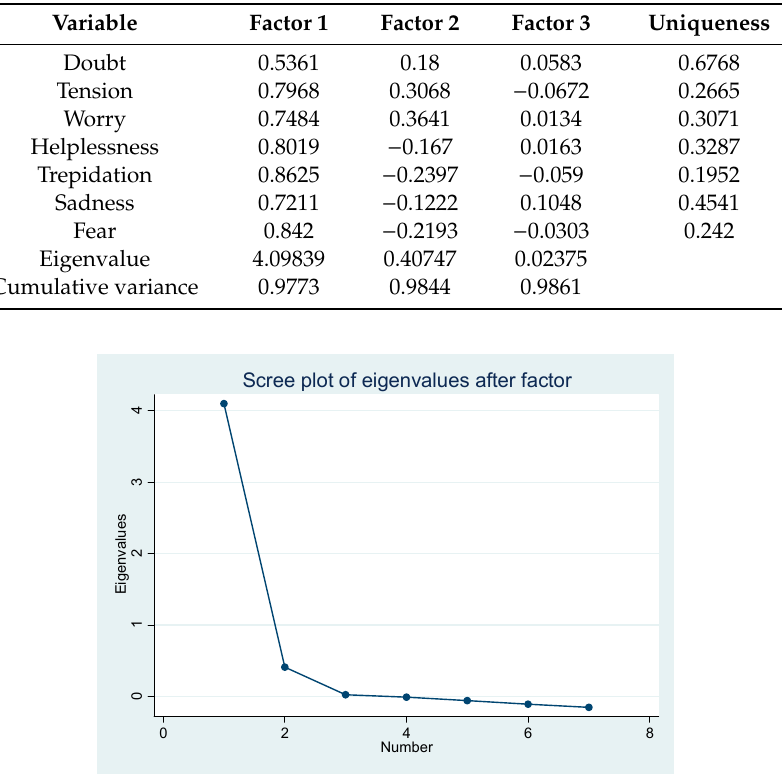
Figure 2. Scree plot of eigenvalues after factor.